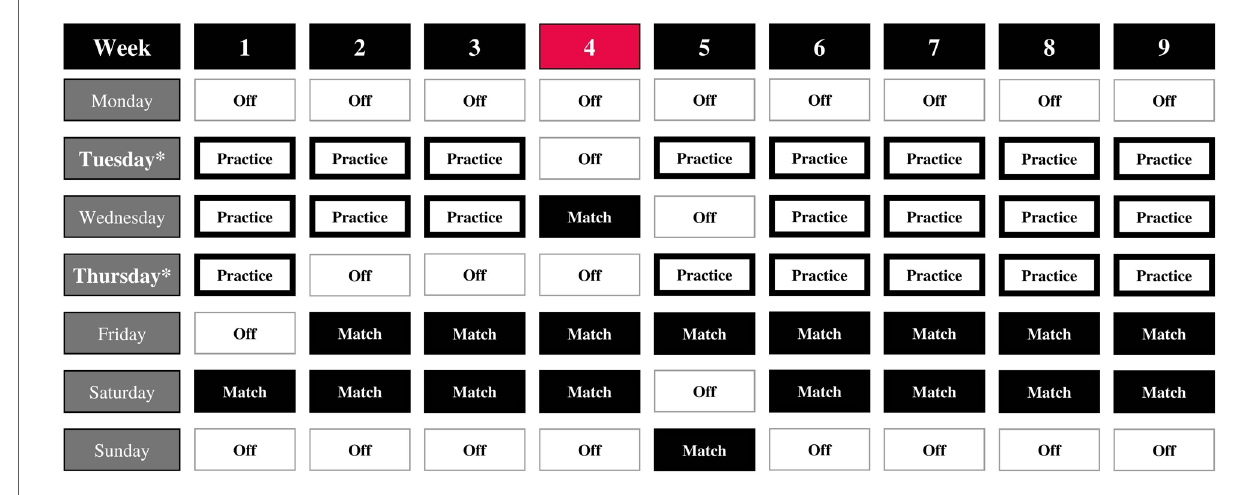
FIGURE 1 Data collection schedule. Red fi ll indicates cross-country travel with missing data for all